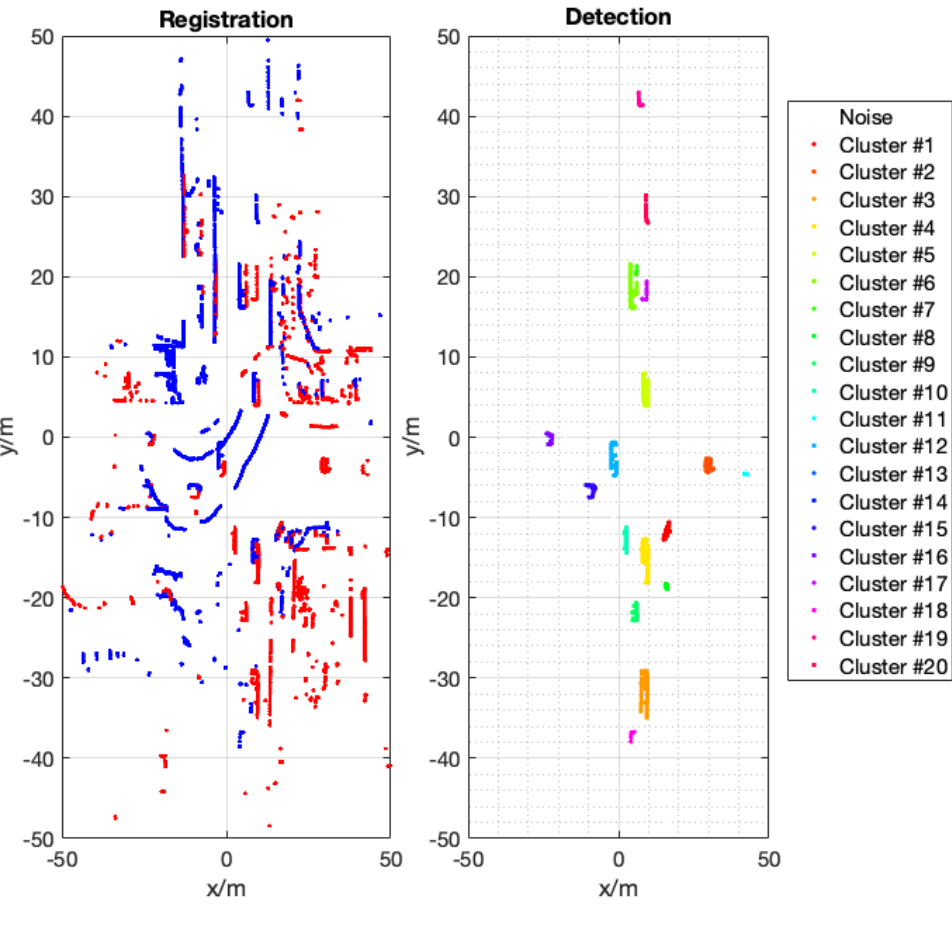
Figure 16. Point cloud registration and vehicle